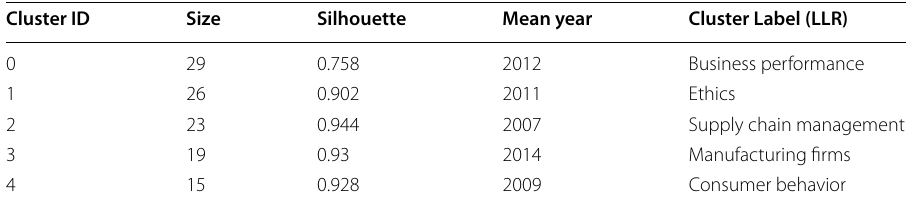
Table 3 Top-ranked clusters and the terms within the clusters (LLR)